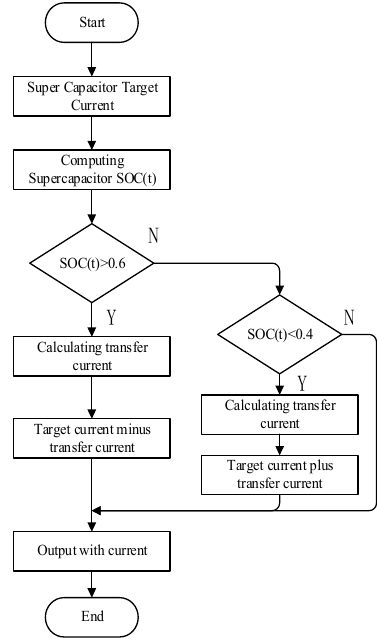
Figure 4. Transfer Current Correction Supercapacitor SOC.